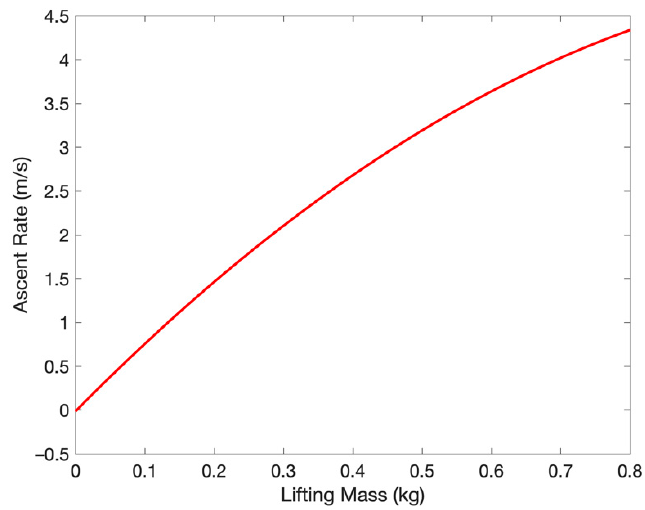
Figure 15. ISM-HAB#3 simulated speed vs. actual speed as a function of time.